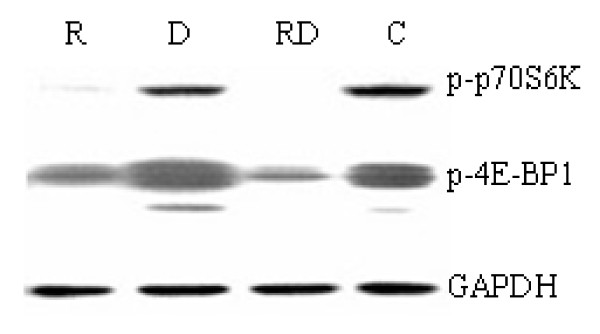
The effect of rapamycin and Dex on mTOR pathway. Molt-4 cells were treated with rapamycin and/or Dex. After 48 h, cells were lysed and followed by Western blot analysis using antibodies specific for the p70S6K phosphorylation sites Thr421/Ser424 and 4E-BP1 phosphorylation sites Thr37/46.